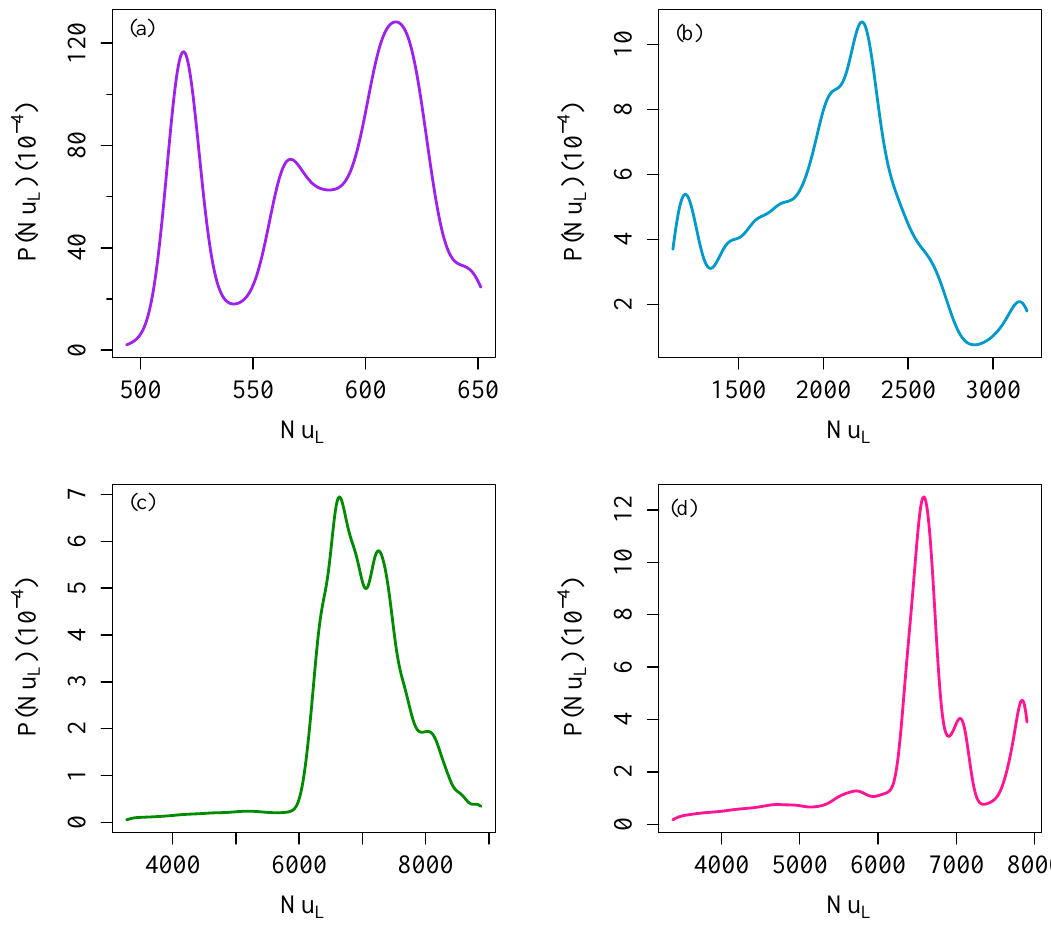
Figure 6. Probability density functions of the instantaneous Nusselt number for ( a ) simulation HC1 ( Pr = 0.1), ( b ) simulation HC2 ( Pr = 1.0), ( c ) simulation HC3 ( Pr = 10), and ( d ) simulation HC4 ( Pr =